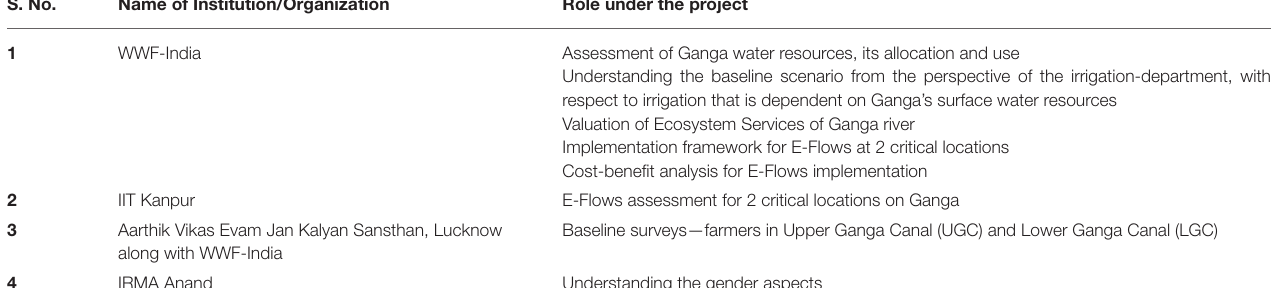
TABLE 1 | Name of institutions, organizations and their role in the project. S. No.